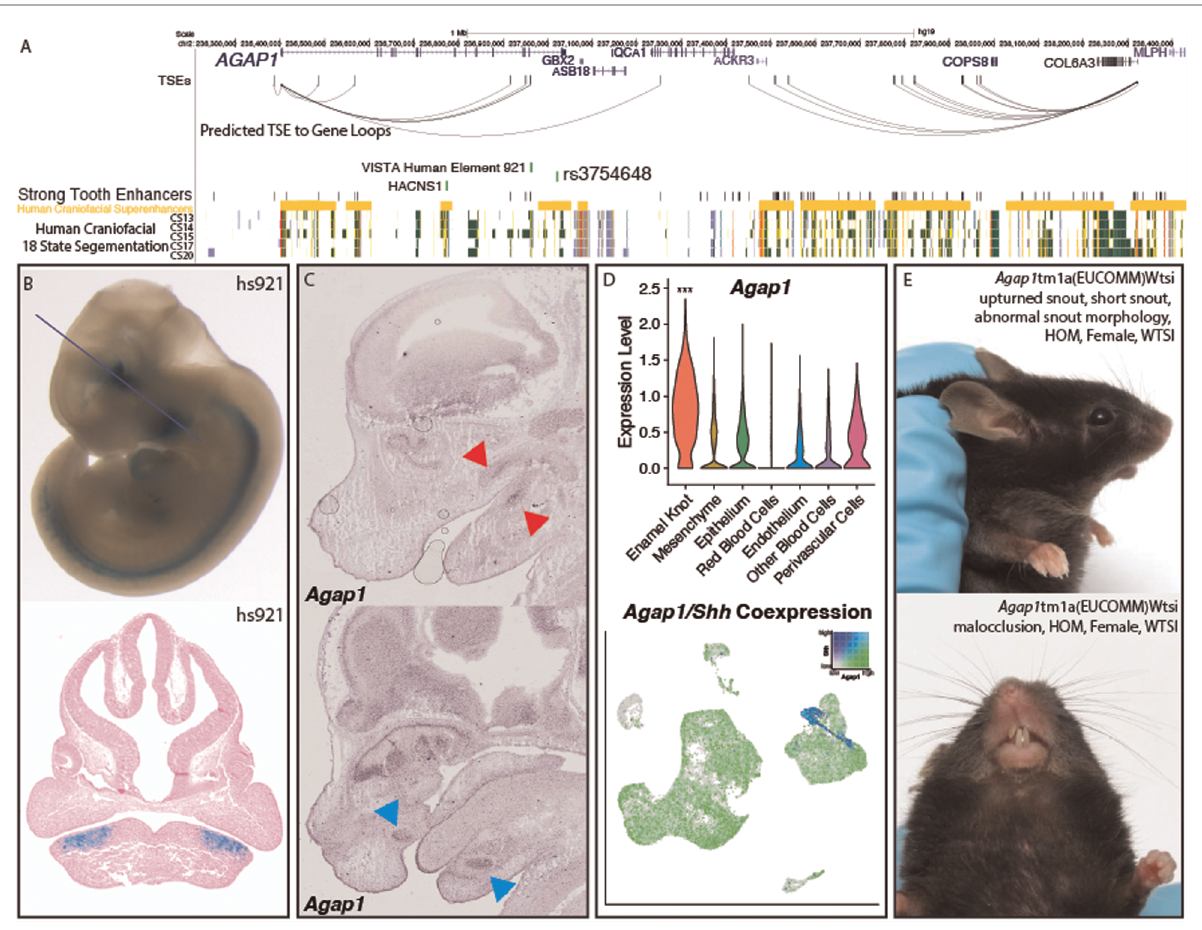
FIGURE 5 Validation of Agap1 as a novel dental disease gene. ( A ) Visualization of the hg19 locus surrounding AGAP1 . TSEs, strong tooth enhancers, and predicted TSE to gene loops were determined as described (Methods) using mm10 coordinates and lifted to hg19. ( B ) VISTA-validated enhancer hs921 demonstrates activity in the pre-mandibular pharyngeal arches, where it is limited to the approximate pre-dental regions. Images from VISTA (89). ( C ) Agap1 expression is apparent in both the maxillary and mandibular molars (top, red arrows) and incisors (bottom, pink arrows). in situ hybridization images from GenePaint http://genepaint.org/viewer/setInfo/ES2973 (74 – 77). ( D ) Single cell transcriptomic analysis demonstrated the PEK-speci fi c expression of Agap1 in the E14 mouse molar. p <0.05, Wilcoxon test. ( E ) Agap1 loss of function mutations in mice result in malocclusion and abnormal facial feature phenotypes at 13 weeks postnatal age. Images from KOMP